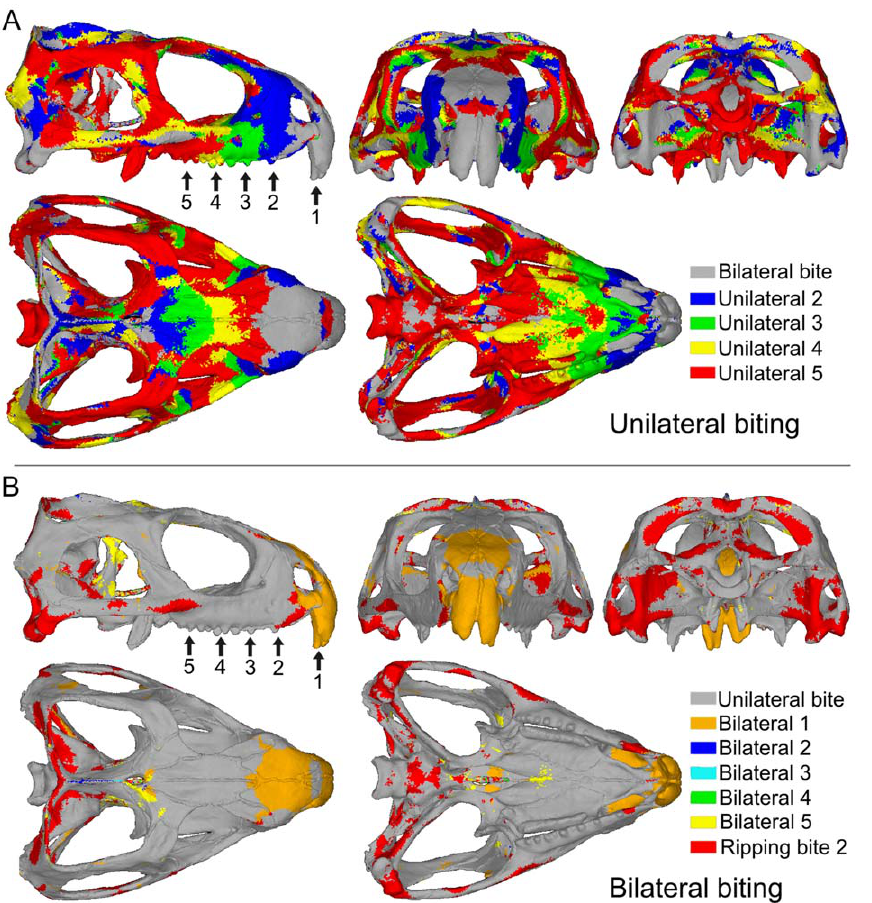
Figure 5. Models showing which bite location generated the highest strains in particular areas of the skull. Results based on von Mises strains. A. Unilateral bites and B. bilateral bites. (For example, in A. unilateral biting at location 2 was responsible for the highest strains in those areas coloured blue).